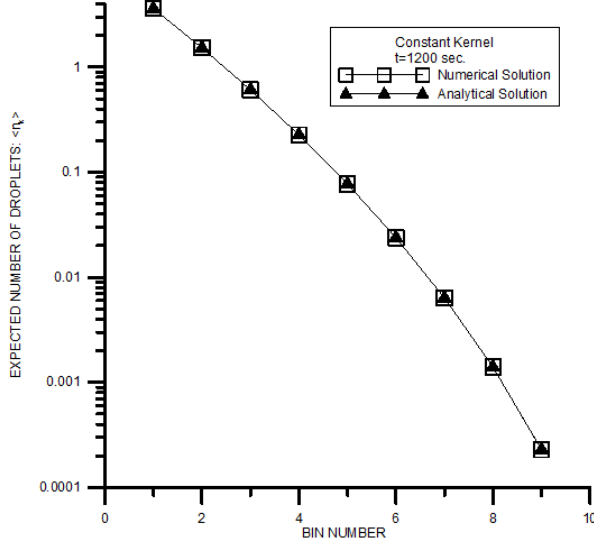
Figure 3. For the sum kernel, size distribution obtained from the analytical solution of the master equation (triangles) and the numer- ical algorithm (squares) at t = 1200s. Calculations were performed with the initial condition P( 10 , 0 , 0 ,..., 0 ; 0 ) = 1 and the sum ker- nel K(i,j) = B(x i + x j ) , with B = 8 . 82 × 10 2 cm 3 g − 1 s − 1 .